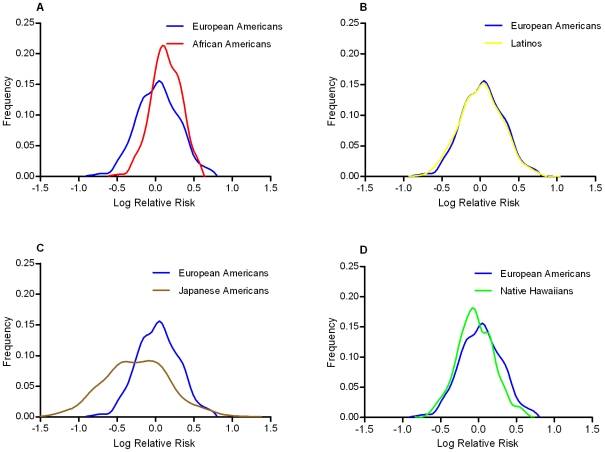
Predicted distribution of T2D risk from common variants by racial/ethnic group compared to European Americans.Comparison of the predicted risk distributions conveyed by the risk alleles relative to European Americans (Blue in Panels A–D): Panel A, African Americans (Red); Panel B, Latinos (Yellow); Panel C, Japanese Americans (Brown); Panel D, Native Hawaiians (Green). The x-axis is the log relative risk for each population centered (at log RR = 0) around the average total risk allele count in the multiethnic sample (18.5). The y-axis is the relative frequency of the population with that level of risk.